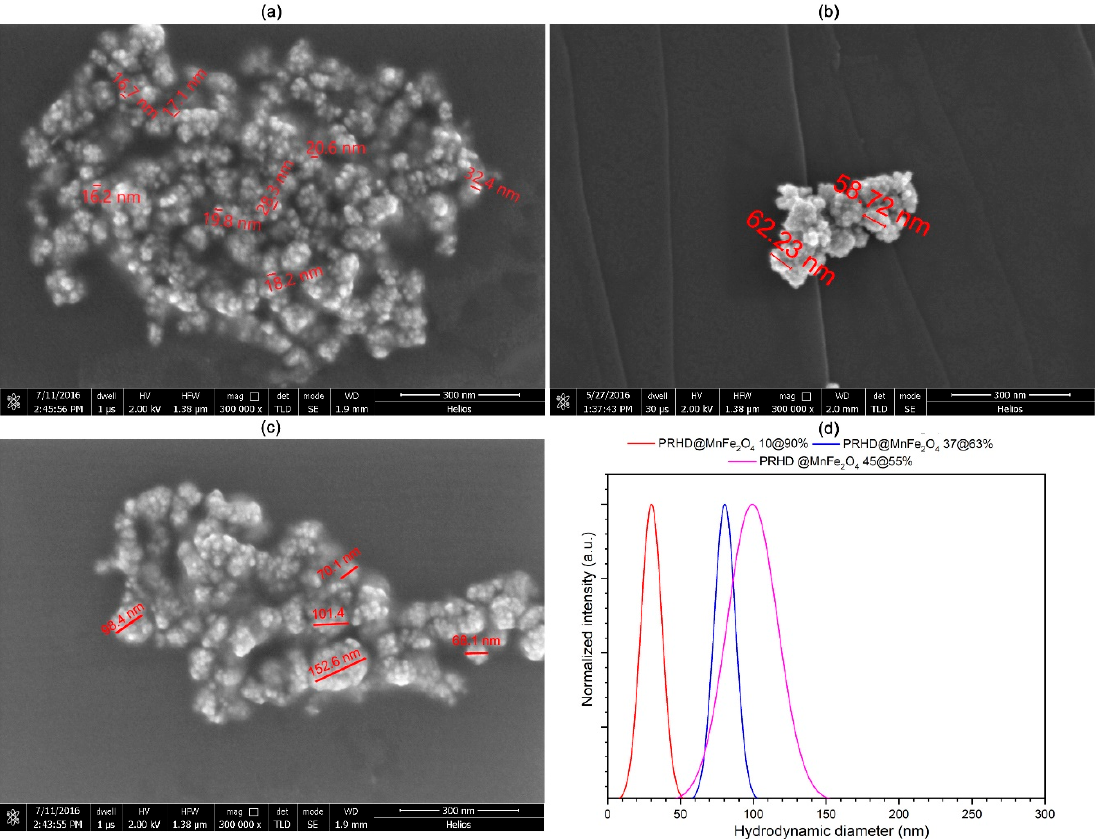
Figure 5. SEM images ( a – c ) and hydrodynamic size ( d ) of hybrid materials with different ratios (%) of PRHD vs. MnFe 2 O 4 ( a ) 10/90, ( b ) 37/63, and ( c ) 45/55.